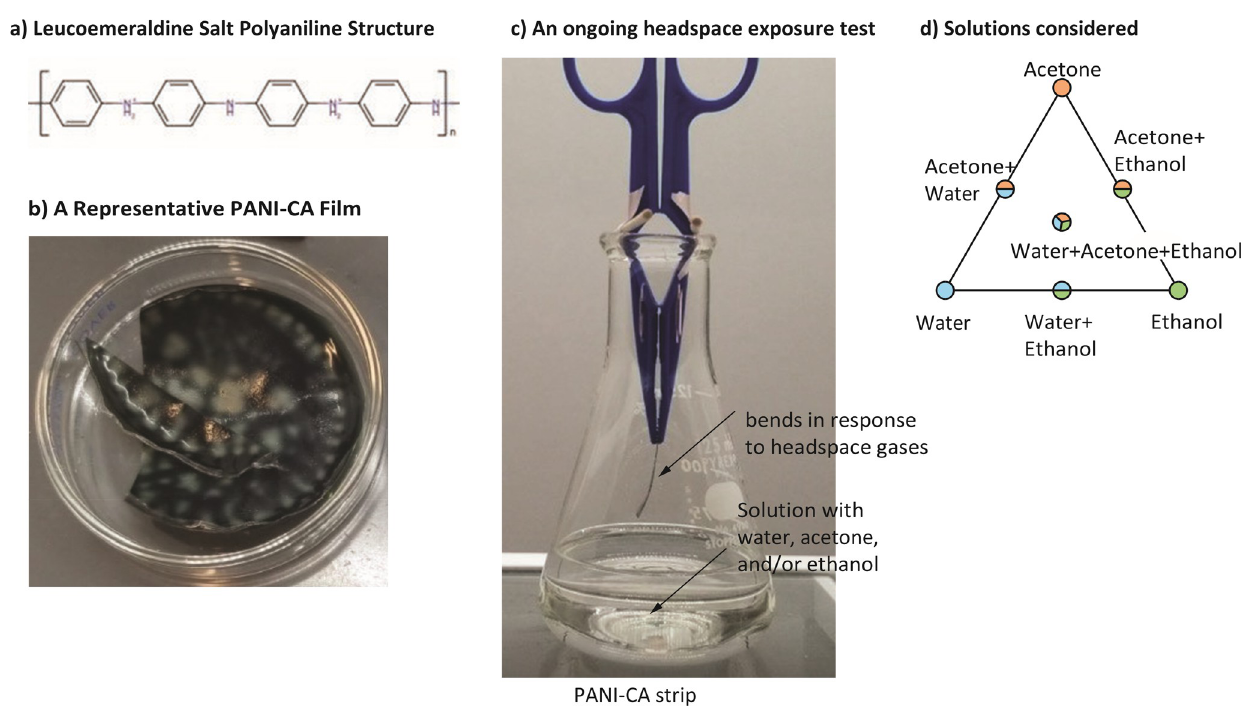
Fig 1. A novel chemo-mechanical actuator. (A) The structure of leucoemeraldine salt of PANI. (B) A film of polyaniline cellulose acetate (PANI-CA) composite. (C) A PANI-CA film bending in response to gases in the headspace of the conical flask. The solution in the flask has water, acetone, and/or ethanol.